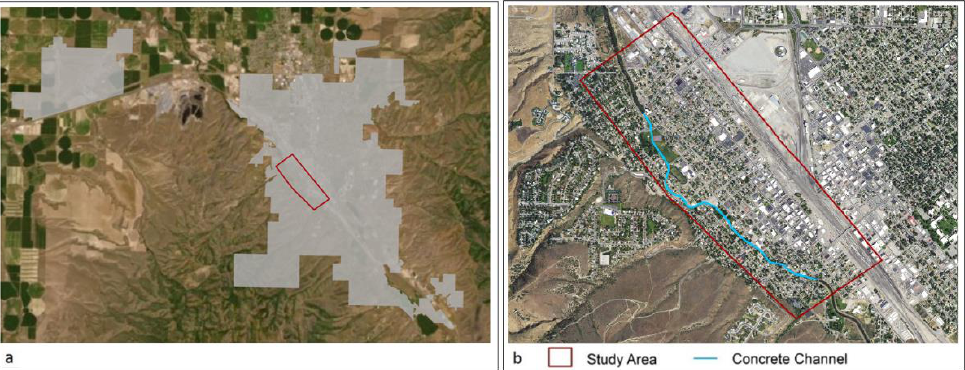
Figure 1. ( a ) Pocatello Old Town. The red section highlights the study area within the City of Pocatello limits. The section inside the red boundary in ( b ) is the study area, and the blue line is the concrete channel section of the Portneuf River. Table 1. Vector data sources.